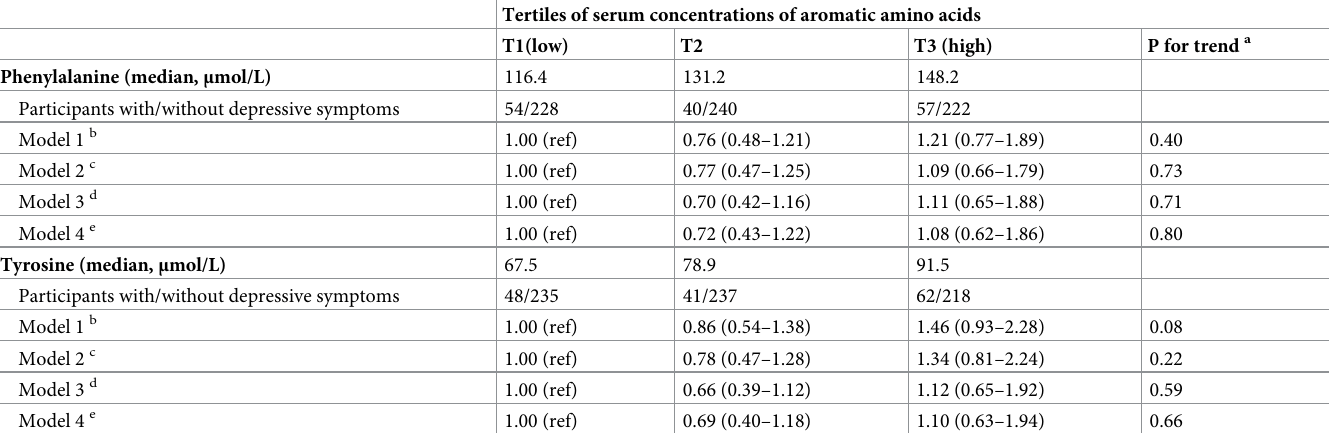
Table 4. Associations of serum concentrations of aromatic amino acids with depressive symptoms. Tertiles of serum concentrations of aromatic amino